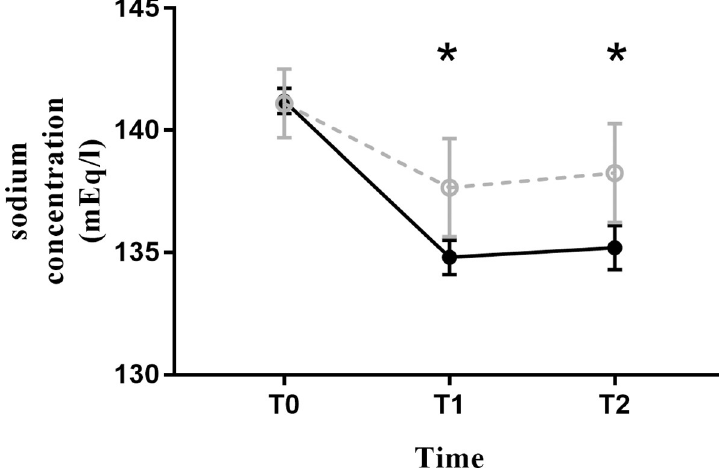
Fig 4. Plasma sodium concentration. Solid line: HYPO. Dashed line: ISO. Asterisk( � ) represents statistically significant values between the two groups.